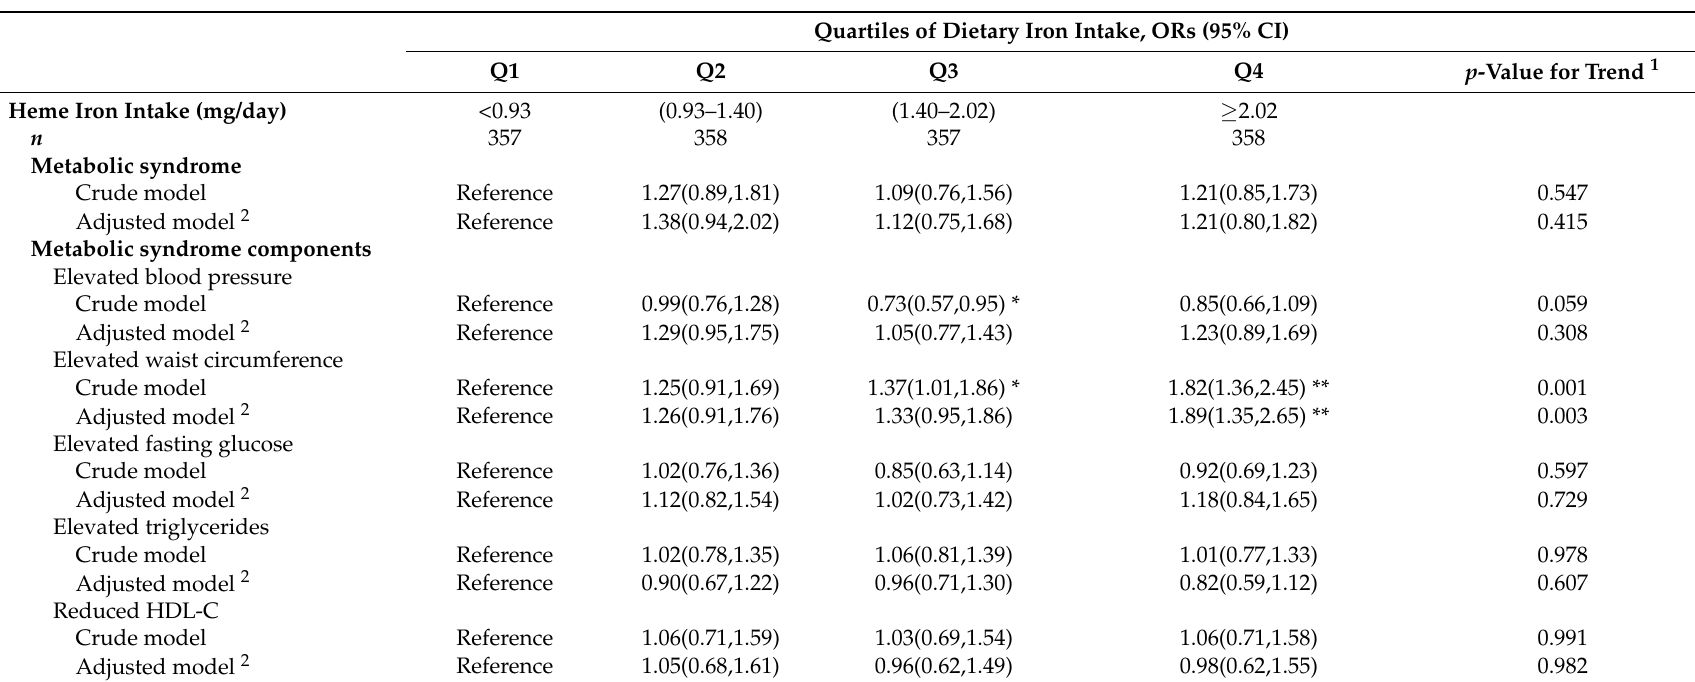
Table 6. ORs (95% CI) for metabolic syndrome and its components according to the quartiles of heme iron intake (mg/day) among men in the SDHS 2012–2013.